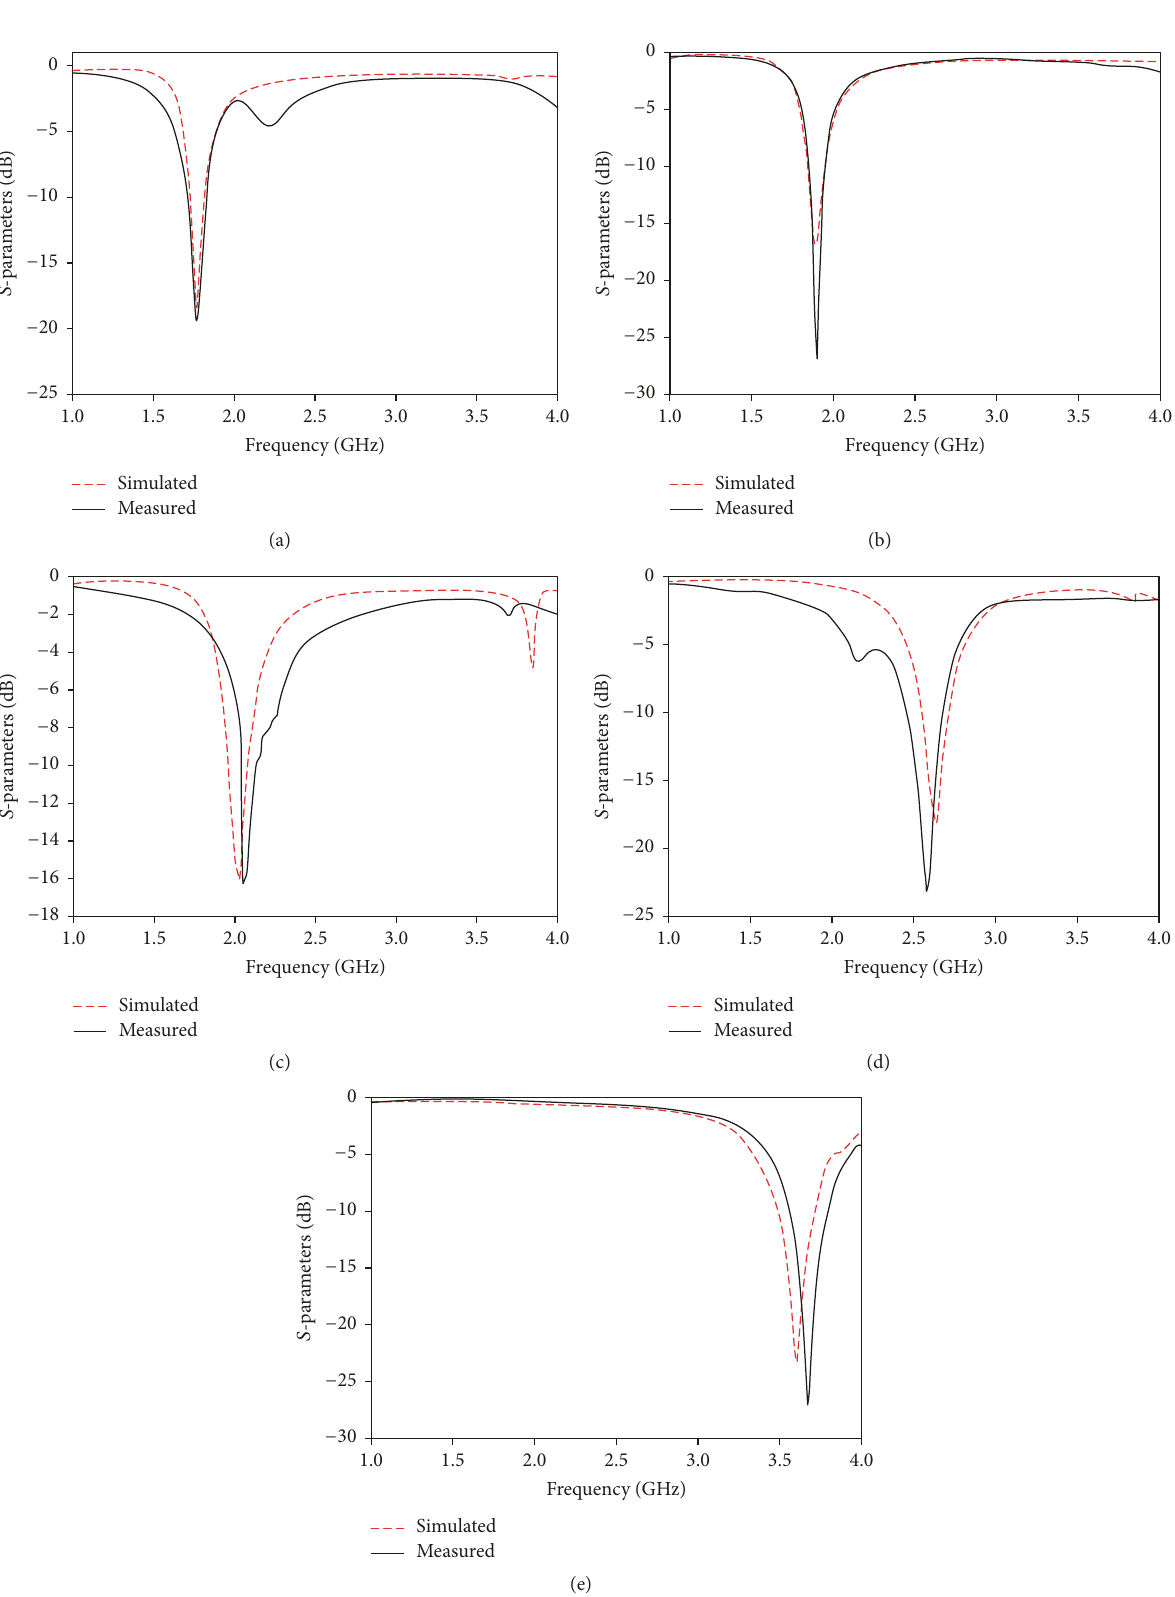
Figure 16: Simulated and measured 𝑆 -parameters corresponding to five configurations. (a) Config-I, (b) Config-II, (c) Config-III, (d) Config- IV, and (e)